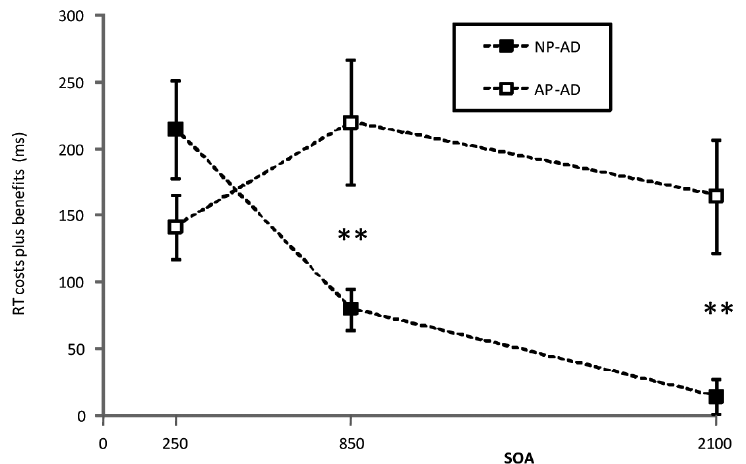
Fig. 2. Mean RT costs plus bene fi ts for each SOA (250 ms, 850 ms and 2100 ms) condition in the two subgroups of AD. Figure 2 illustrates the costs plus bene fi ts for each SOA in the two AD subgroups. Data are presented as mean (SE) RTs for each group. The RT costs plus bene fi ts of the “abnormal pattern” AD subgroup (AP-AD) and those of the “normal pattern” AD subgroup (NP-AD) were signi fi cantly different by the ANOVA with repeated measures ( F = 5.86, p = 0.03). A signi fi cant effect of interaction was found ( F = 11.73, p < 0.001). Signi fi cant effects of the SOA were also found ( F = 10.21, p < 0.001). AD = Alzheimer’s disease, NP-AD = AD of normal pattern, AP-AD = AD of abnormal pattern, SOA = stimulus onset asynchrony, ms = milliseconds, The white squares were the results of the NP-AD subgroup while the black circles were those of the AP-AD